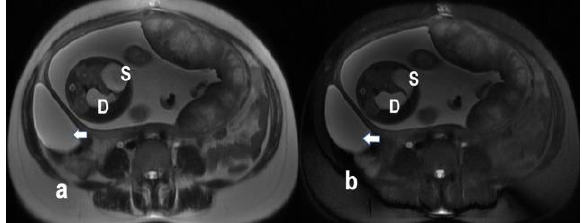
Figure 2: Axial single-shot fast spin-echo with breath-hold (a) and fat-saturated (b) MR images confirming the ultra-sound findings. Dilated fetal stomach (S) and duodenum (D) were seen. Maternal right ovarian cyst showed benign features with no evidence of septation or nodule (arrow).